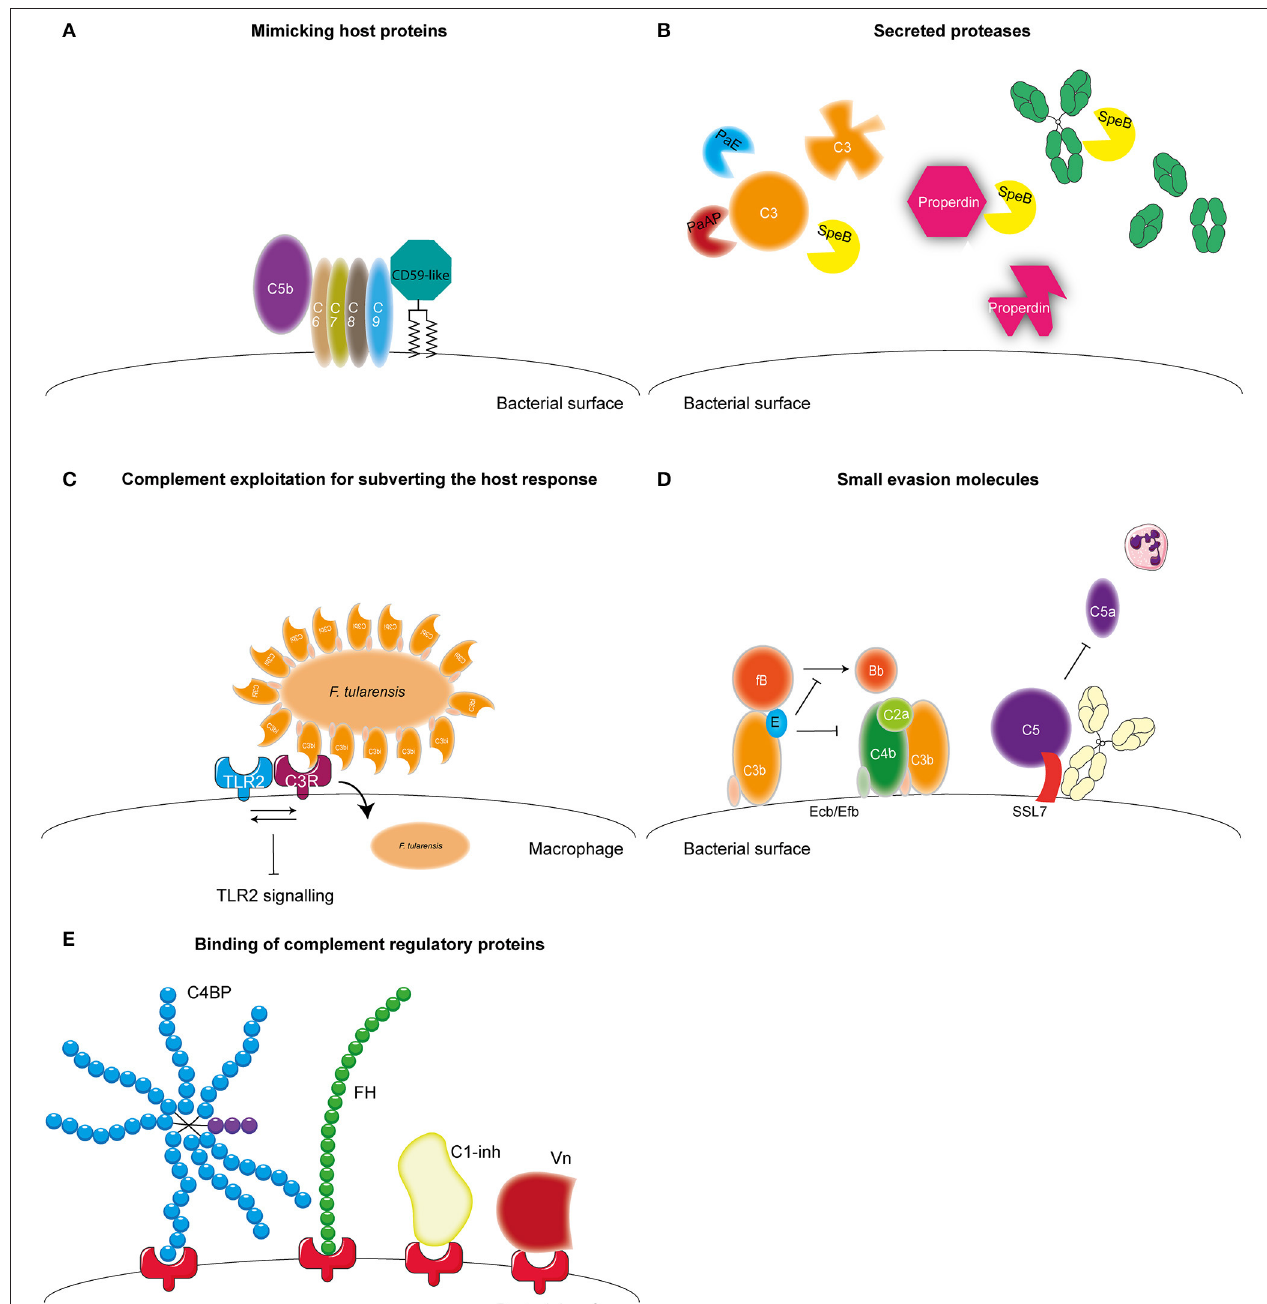
FIGURE 3 | Complement evasion strategies of bacteria. Complement evasion strategies of bacteria can be divided into four different groups. (A) The expression of proteins that mimic host structures like the CD59-like protein of B. burgdorferi which inhibits MAC formation. (B) The secretion of bacterial proteases like PaE and PaAP expressed by P. aeruginosa which cleave C3. S. pyogenes SpeB cleaves C3, properdin and IgG. (C) Inhibition of TLR2 by F. tularensis. This bacterium exploits being opsonized by C3b to engage CR3 on macrophages to facilitate entry as well as to induce both inside-out as well as outside-in signaling of CR3 resulting in decreased TLR2 activity. (D) The secretion of small bacterial proteins with complement inhibitory properties as is shown for S. aureus . This pathogen secretes Ecb and Efb that bind to the C3d domain of C3b and thereby inhibit the formation of the C3b containing CP and LP C5 convertase as well as inhibit the formation of the AP C3 convertase by stabilizing the binding of FB to C3b preventing cleavage of FB into Bb. Furthermore, SSL7 is secreted which binds C5 and IgA inhibiting the generation of C5a and thus subsequent neutrophil infiltration. (E) The recruitment of fluid phase complement regulatory proteins C1-inh, C4BP, FH, and Vn to the bacterial membrane which will be discussed in this review. Figure was produced using Servier Medical